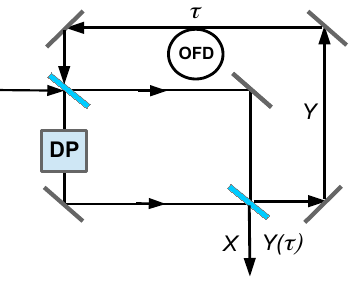
Figure 2. Basic setup of a OFD device.